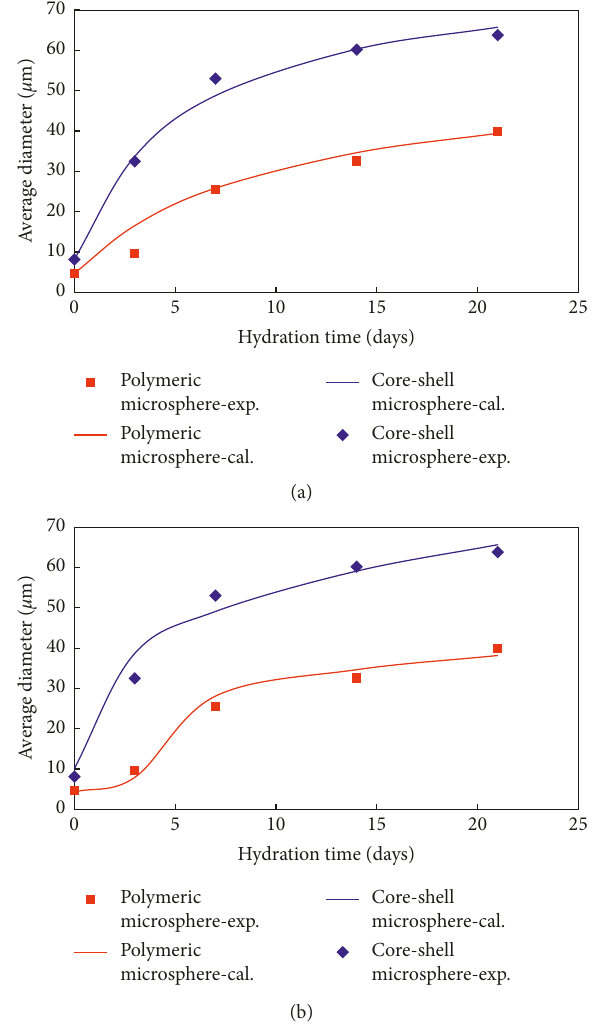
Figure 8: Matching curves of microsphere average diameters by (a) traditional model (1) and (b) proposed model